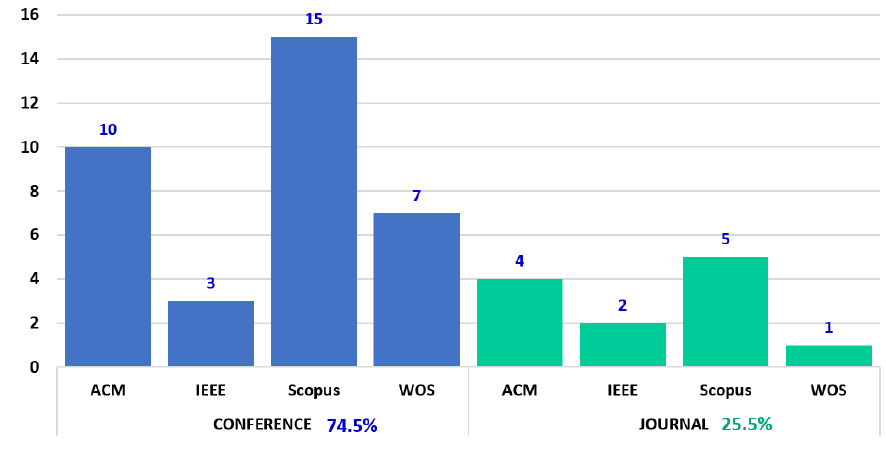
Figure 5. Documents by type.